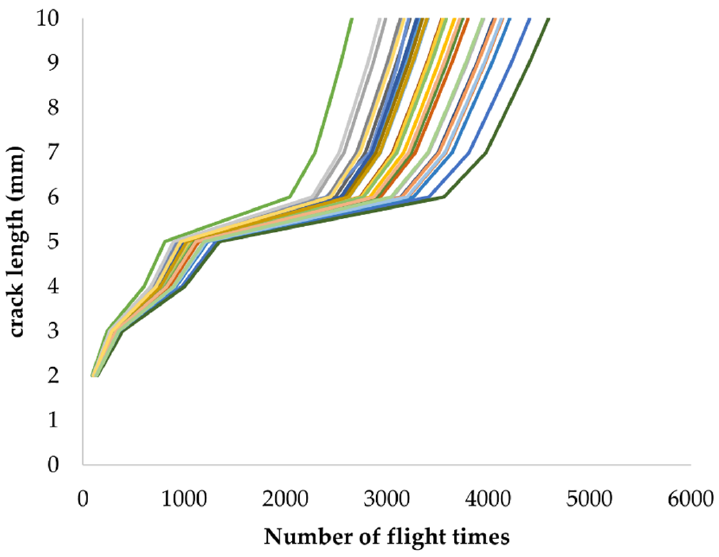
Figure 12. Fatigue delamination behavior of DOE data generation scenarios.